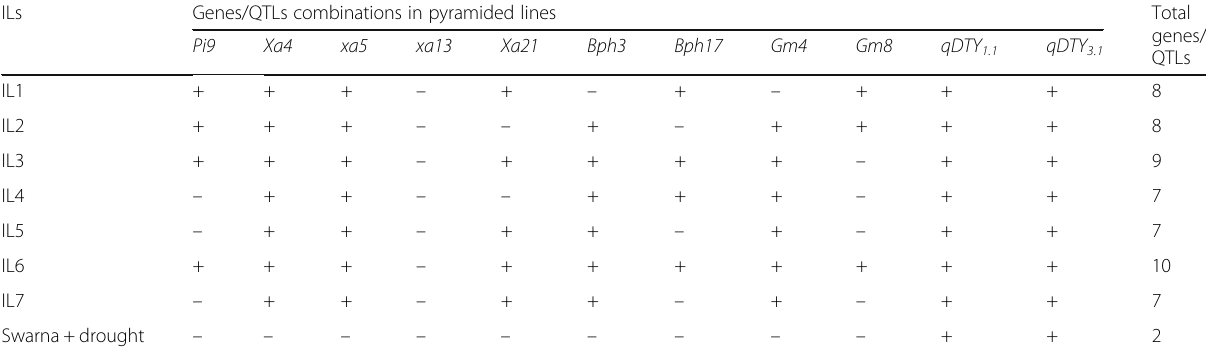
Table 1 Genes/QTLs information of the identified pyramided introgression lines ILs Genes/QTLs combinations in pyramided lines